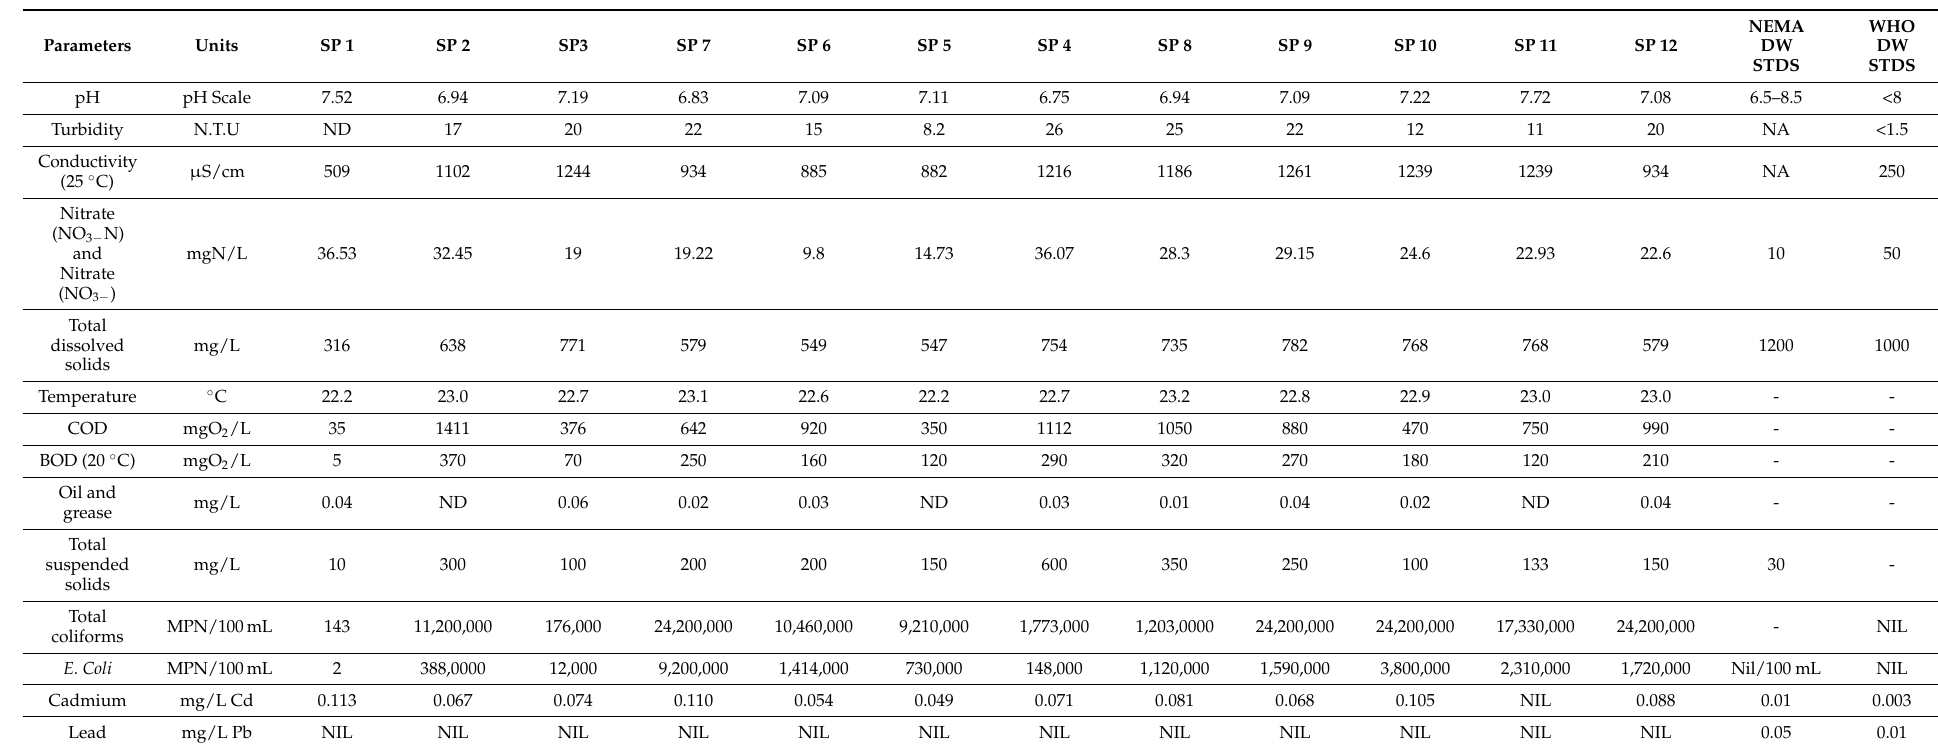
Table 4. Ngong River water quality levels (Dry